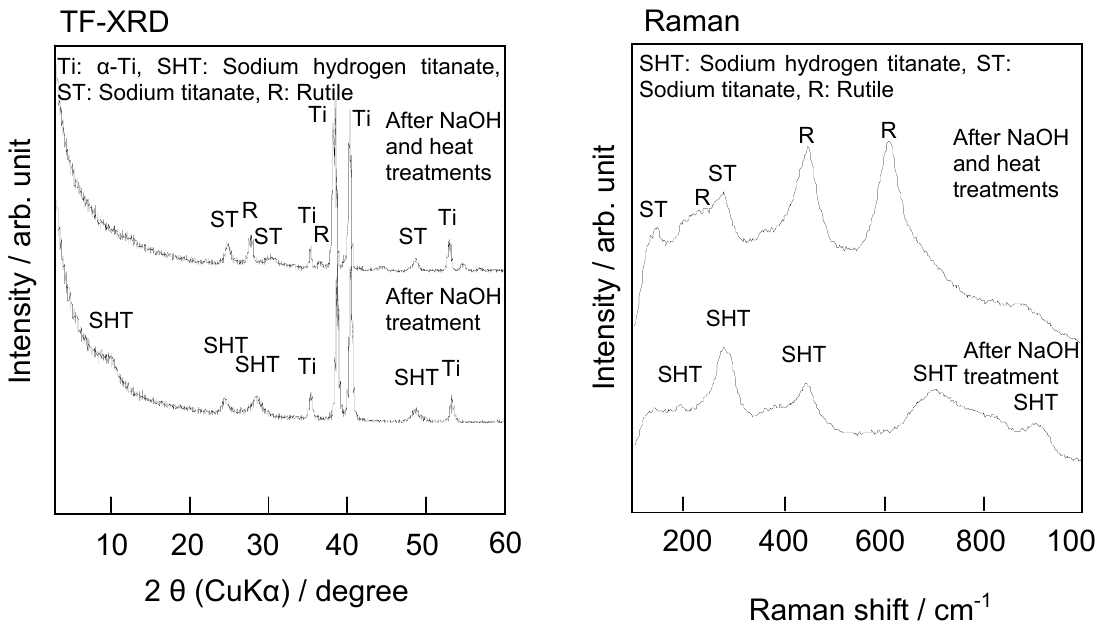
Figure 3. TF-XRD patterns and Raman spectra of surfaces of Ti metals subjected to NaOH and heat treatments.